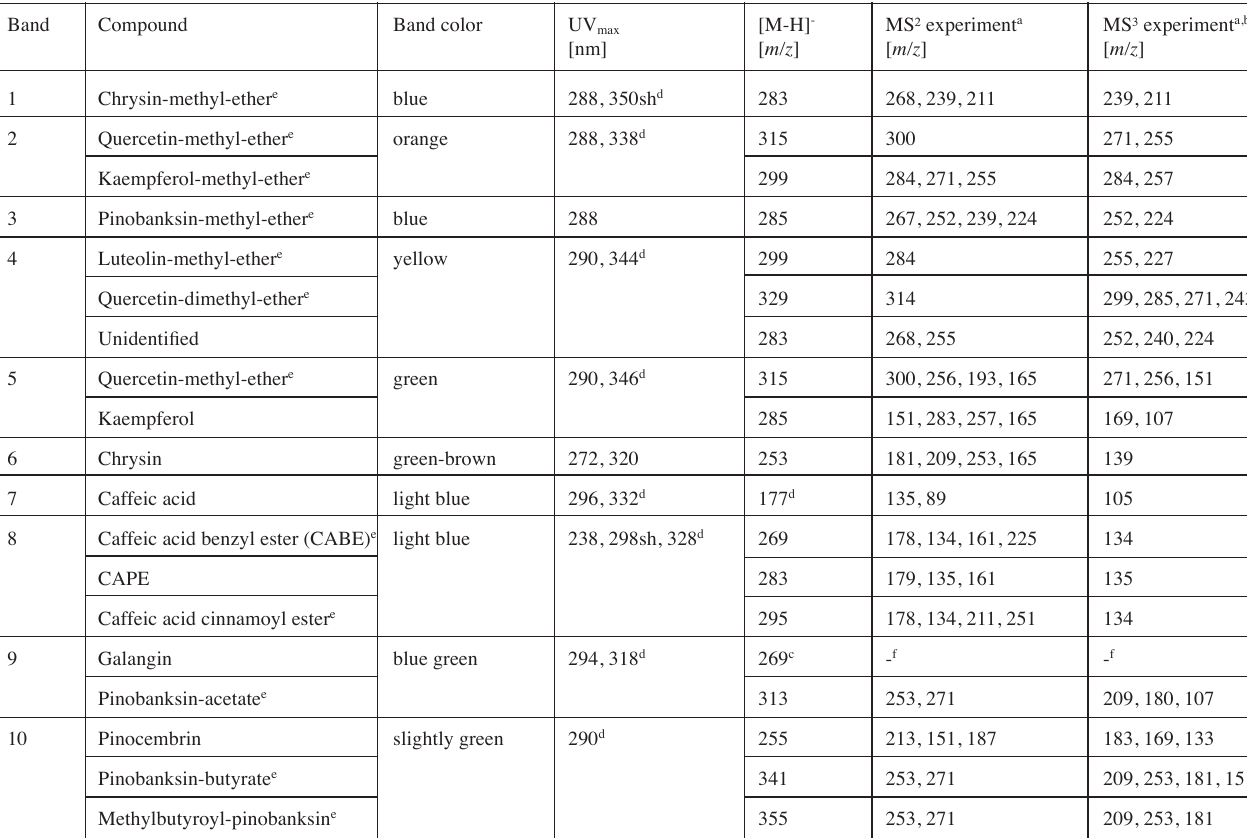
Tab. 2: TLC-MS and UV spectroscopic data obtained from the analysis of a Populus x canadensis Moench ‘ Robusta’ bud extract (see Fig.